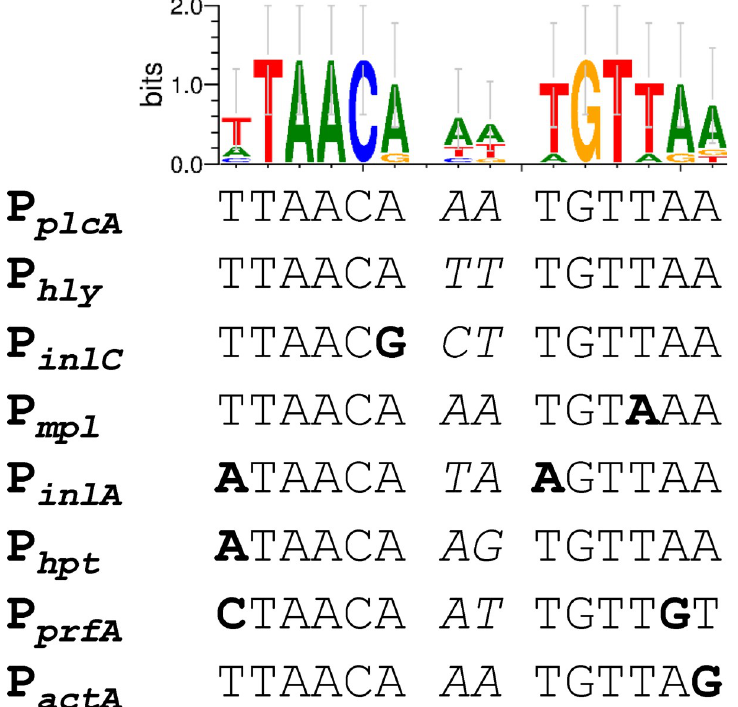
Fig 1. Conservation of the PrfA box sequences in the promoter region of PrfA-regulated genes. The PrfA box sequence WebLogo is presented above a multiple sequence alignment of known PrfA boxes extracted from L . monocytogenes strain 10403S whole genome sequence data deposited in NCBI under the accession number NC_017544.1. Bold letters indicate nucleotides that deviate from providing a canonical PrfA box hairpin. Italicized letters represent non-conserved nucleotides in the spacer